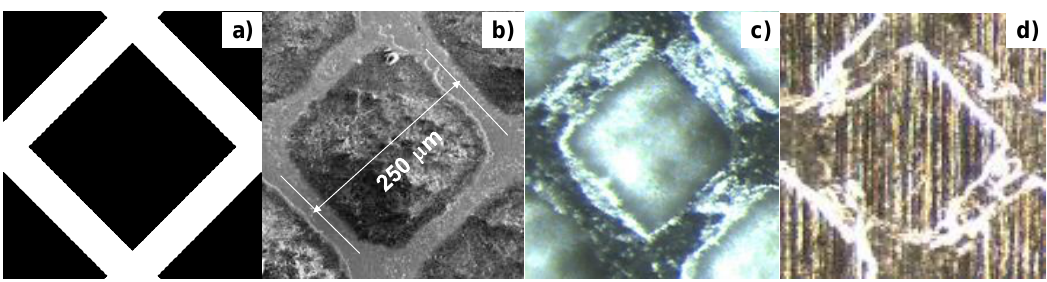
Figure 11. Comparison of the geometric configurations among ( a ) the micropattern on the screen, ( b ) the SEM image of the nitrided AISI316 die, ( c ) the three-dimensional profile of the blasted AISI316 die, and ( d ) the micro-embossed copper plate.